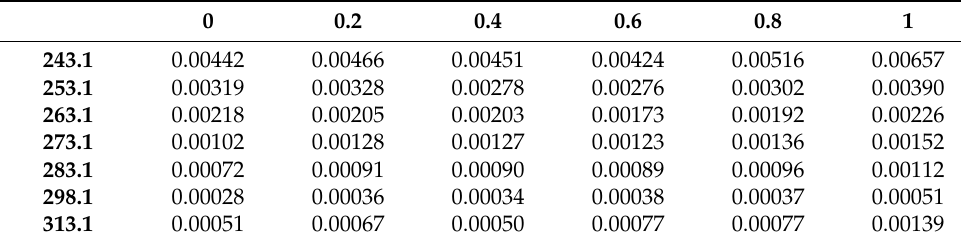
Figure 14. OCV (Open Circuit Voltage) vs. the SOC of the battery pack. Table 4. Internal resistance (expressed in Ohm) of each cell in function to the SOC (from 0 to 1, first row of the table) and to the temperature in Kelvin (from 243.1 K to 313.1 K, first column of the table).